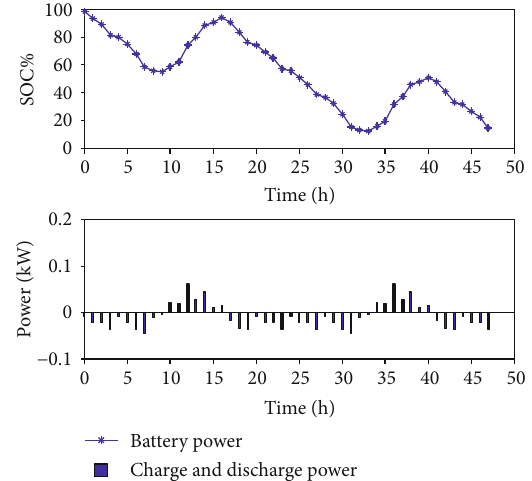
Figure 8: Battery charge state and 48 h charge and discharge power (without